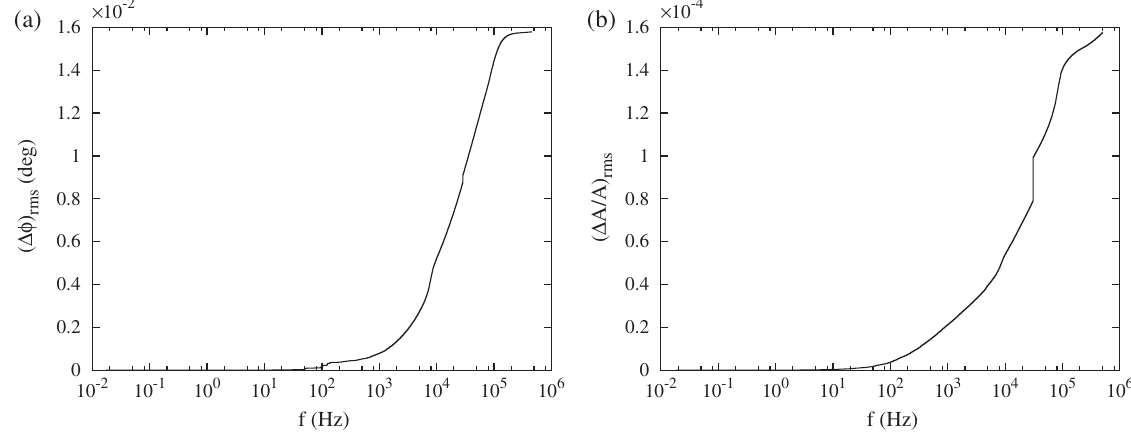
FIG. 7. Integrated spectra of (a) phase error and (b) amplitude error of the GDR. Amplitude and phase feedback are both active.